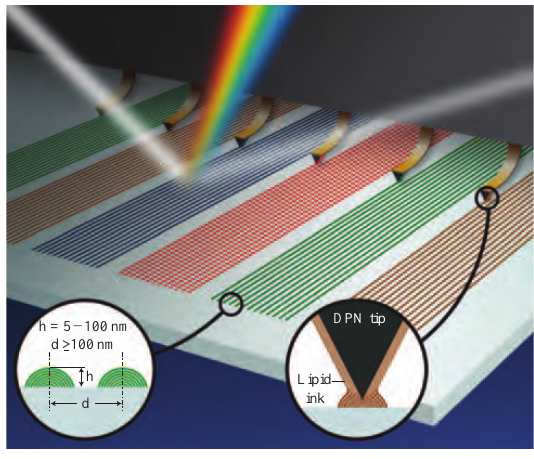
Fig. 1. Dip-pen nanolithography used to fabricate lipid multilayer gratings. Reprinted by permission from [80], Copyright 2010, Macmillan Publishers Ltd.